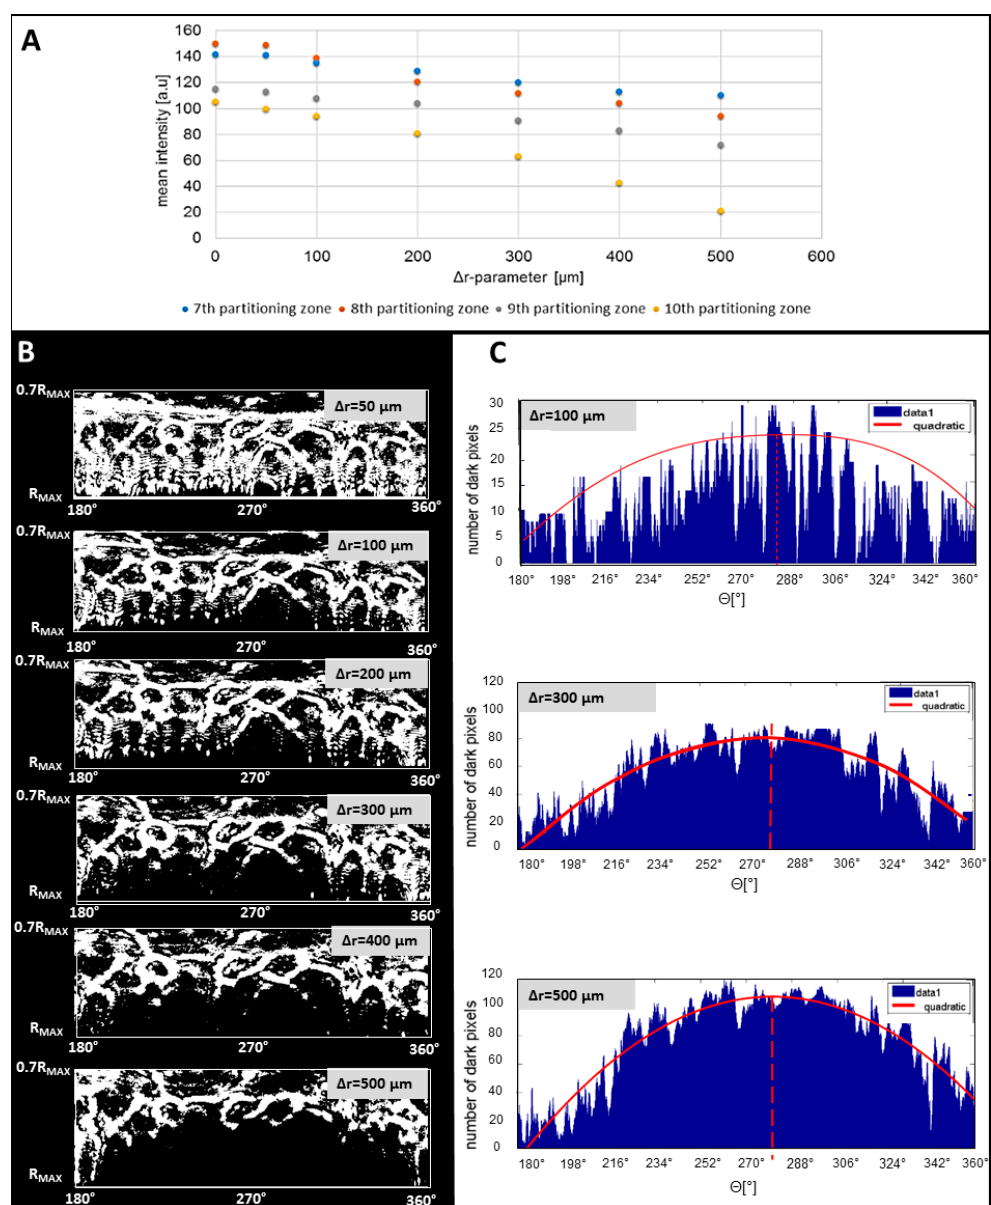
Figure 7. ( A ) Dependence of the mean intensity values from four peripheral partitioning zones on the Δ r-parameter values; ( B ) The representative binary masks of the lower part of processed Fresnel patterns for different Δ r-parameter values and for Θ = 280°; ( C ) The representative dependence of the number of dark pixels for each angle.